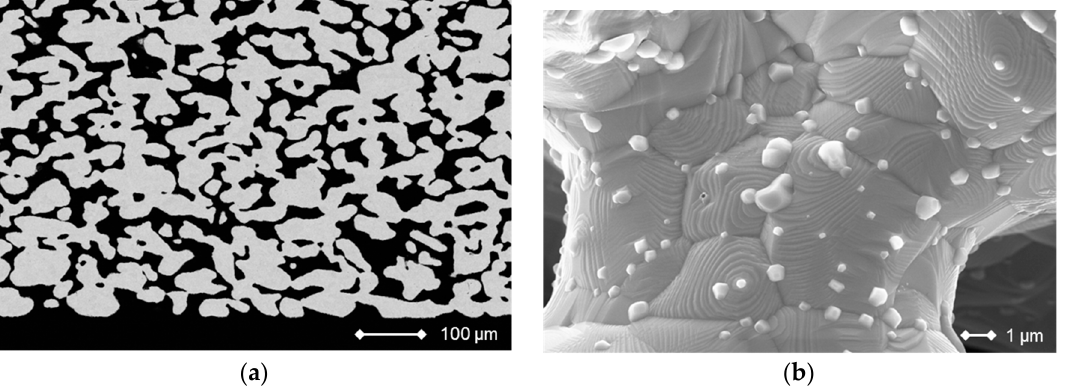
Figure 10. Cross section of the Cr26-Fe substrate material ITM ( a ) and fracture image ( b ). The bright crystals along the grain boundaries were identified as yttria and titania.